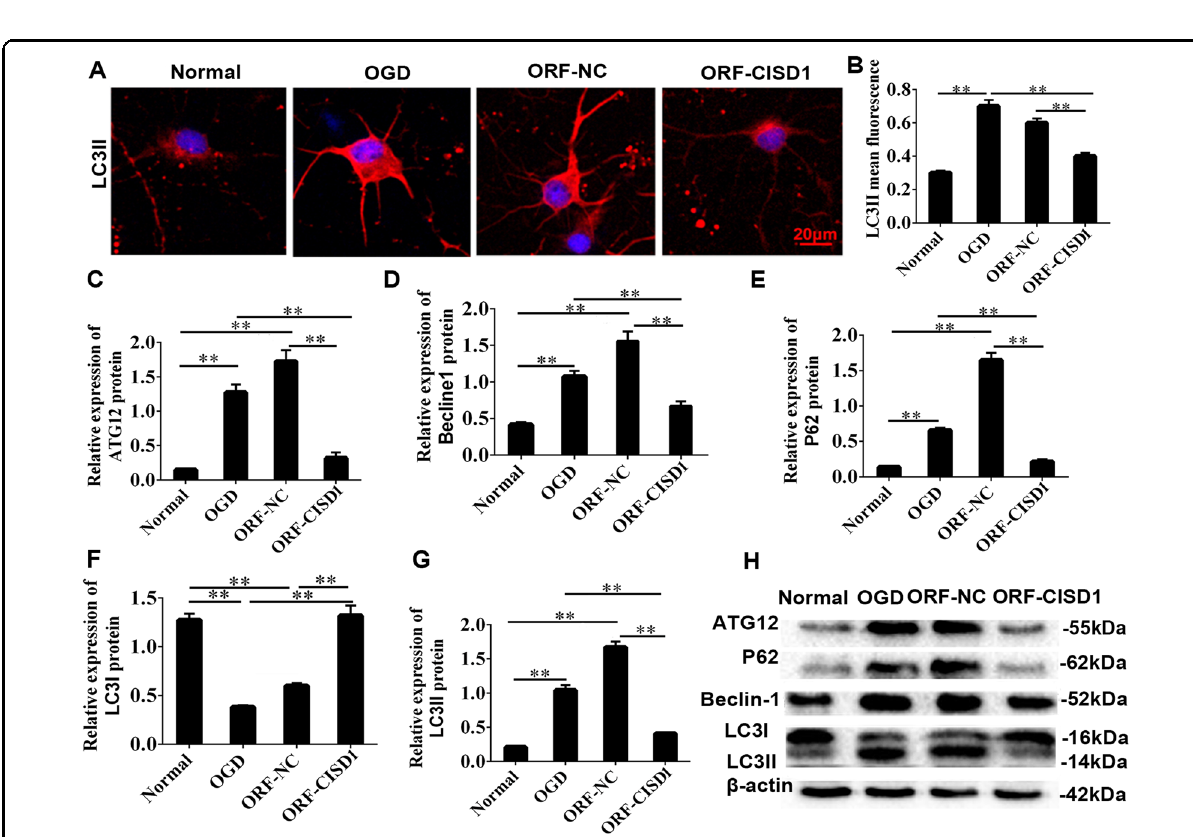
Fig. 7 CISD1 relieved autophagy in vitro. A Autophagy of neurons was increased signi fi cantly in OGD, and reduced signi fi cantly in ORF-CISD1. B The relative expression of LC 3II was obviously increased in OGD, but reduced signi fi cantly in ORF-CISD1. OGD oxygen glucose deprivation. C – H The relative expression of ATG12, Beclin-1, P62, and LC 3II was obviously increased, and the relative expression of LC 3I was decreased signi fi cantly. However, the expression result of ATG12, Beclin-1, P62, LC 3I, and LC 3II was opposite in the miR127 KO rat group. Scale bar = 20 μ m. Data are shown as mean ± s.d. ** P < 0.01 with one-way ANOVA or Kruskal – Wallis, n = 6. OGD oxygen glucose deprivation, NC negative control, CISD1 CDGSH iron sulfurdomain-containing protein 1, ORF-CISD1 CISD1 overexpression, CISD1-NC negative control